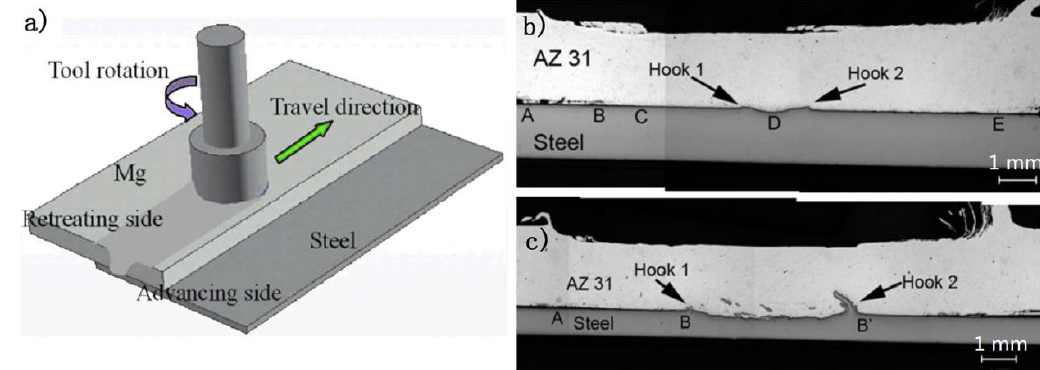
Figure 2. Friction stir lap welding process [15] ( a ) schematic illustrations; ( b , c ) cross-sectional macrograph of AZ31 to 1.5 mm and 0.8 mm steel weld.